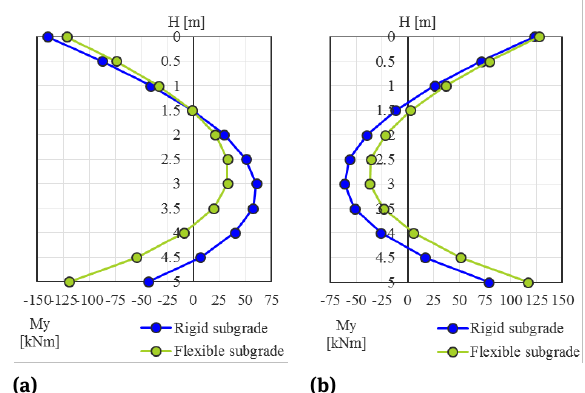
Figure 10: Distribution of bending moments in bridge bottom slab Along the whole length of the bridge’s bottom slab the value of bending moment M y is higher in the model which takes subgrade elasticity into account than in the model on a rigid subgrade. If subgrade elasticity is not taken into account in the model, this can lead to the cracking of the top surface of the slab in the middle of its span and to the cracking of the bottom surface at the side walls. The bend- ing moment values for which the bridge was designed are given in Table 6.